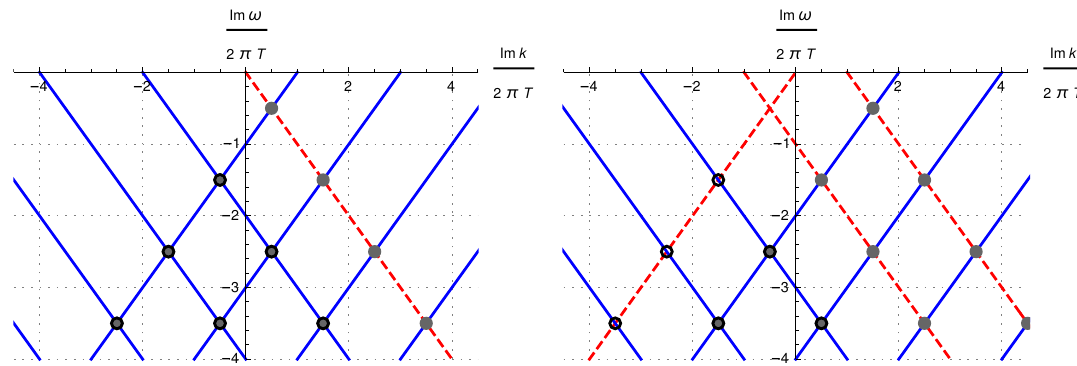
Figure 3 . Comparison of the locations of the pole-skipping points predicted by the near-horizon analysis (gray and hollow points) and the locations of the intersections of the lines of poles (blue) and lines of zeros (red, dashed) of the exact boundary retarded Green’s function for half-integer values of the conformal dimension. We see that the non-anomalous pole-skipping points (either hollow or gray, but not gray with black circle) perfectly match the locations of the intersections. The anomalous pole-skipping points (gray with black boundary) correspond to the locations where two lines of poles intersect. The physical interpretation of these anomalous points is still